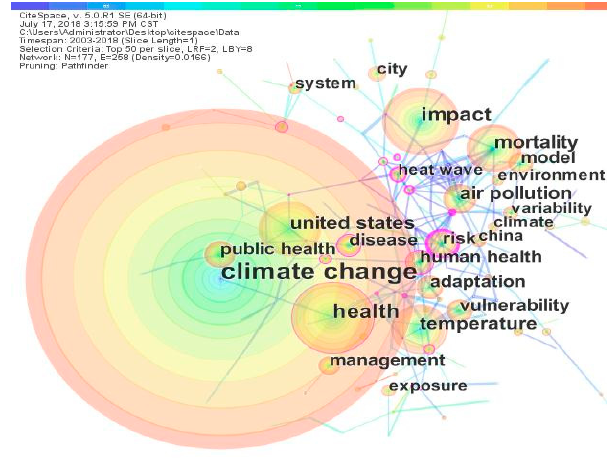
Figure 9. Keywords co-occurrence network.